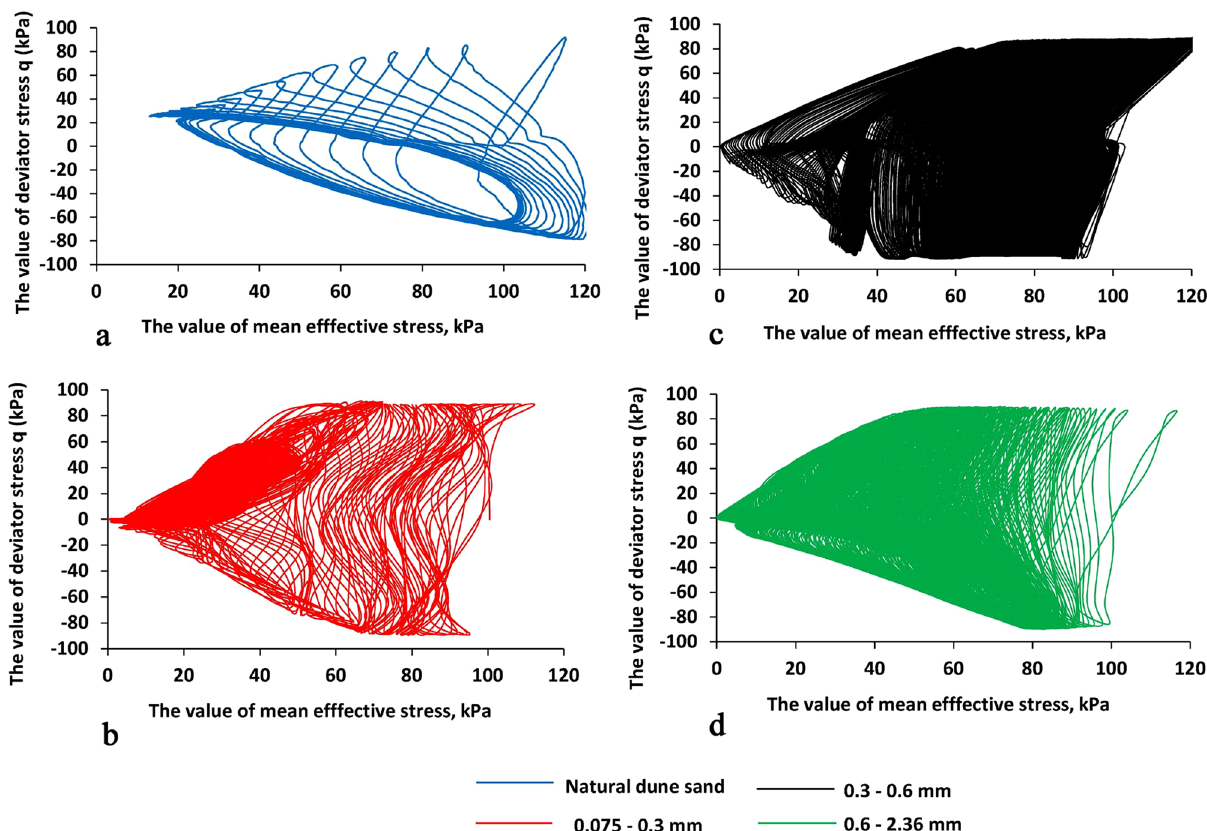
Figure 8. The value of deviator stress (q, kPa) vs. the value of mean effective stress (p ′ , kPa), the X-axis is the value of mean effective stress (p ′ , kPa), and the Y-axis is the value of deviator stress (kPa). The blue, green, black, and red lines are for natural dune sand, fractions 2.36–0.6, 0.6–0.3, 0.3–0.075 mm, respectively.